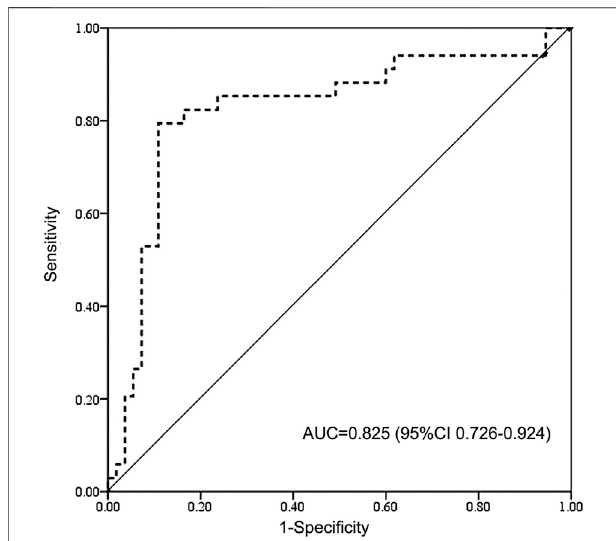
FIGURE 2 | Receiver operating characteristic (ROC) curve of high BU exposure for SOS and GVHD. BU AUC of 9.27 mg/L × h cut point indicates 85% sensitivity and 71% speci fi city on high-exposure-related toxicity. BU AUC, area under the concentration-time curve of busulfan; AUC, area under the curve for ROC curve; CI, con fi dence interval; GVHD, graft vs. host disease; SOS, sinusoidal obstruction syndrome.